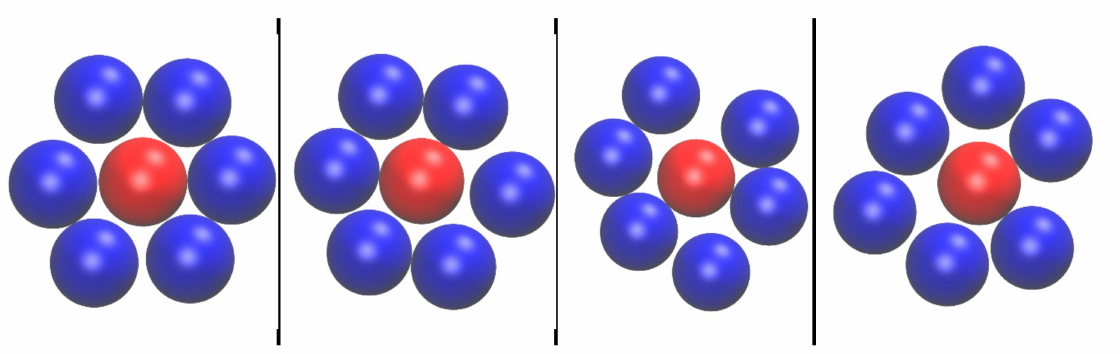
Figure 13. Computer-generated, local structures with progressively reduced TRI-similarity and thus with increasingly high TRI-CCE norm. From left to right: ε TRI = 0.05, 0.10, 0.20 and 0.30. The latter case is not characterized as TRI-like since ε TRI > ε thres = 0.245. Reference site and nearest neighbors are shown in red and blue, respectively. Image created with the VMD software. Each figure panel is also available as stand-alone image in 3-D, interactive format in the Supplementary Materials. Table 9. Statistics of the Voronoi polygon of computer-generated local structures, visualized in Figure 13, with progressively poor triangular singularity as quantified by the corresponding CCE norm, ε TRI : coordination number N coord ( X ), number of vertices V ( X ) and edges E ( X ), surface area A VP ( X ),